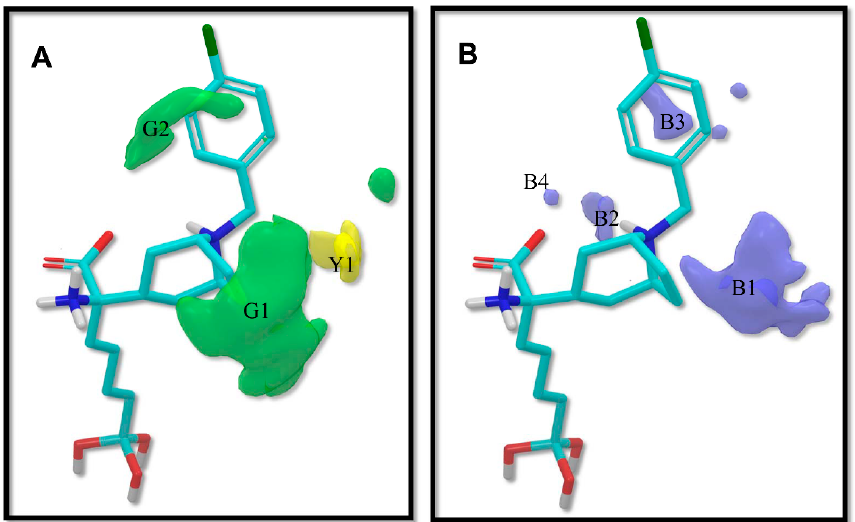
Figure 3. 3D-QSAR contour maps for ABH derivatives (SE model): ( A ) steric field, where green isopleths indicate regions where bulky groups enhance the activity, and yellow isopleths indicate regions where bulky groups disfavor the activity; and ( B ) electrostatic field, blue isopleths indicate regions where an increase of positive charge enhances the activity. Compound p3_11c is shown inside the fields.